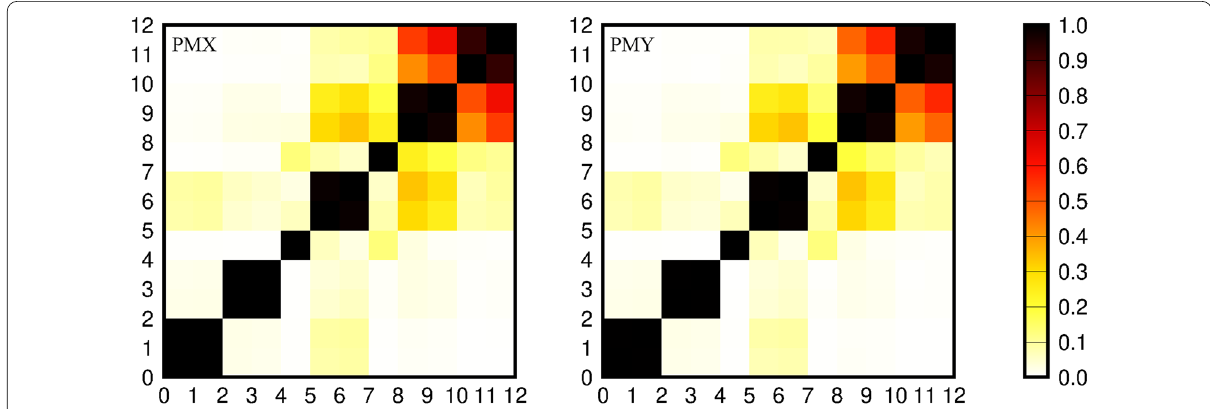
Fig. 2 W-correlations among the first 12